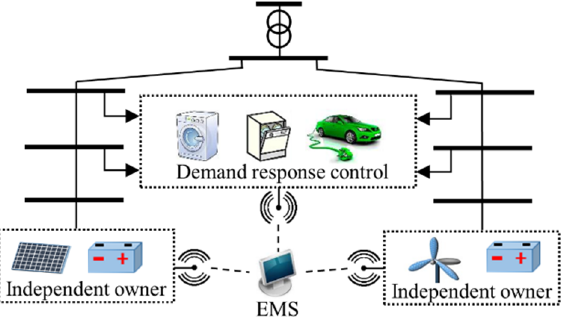
Figure 1. Conceptual image of a smart microgrid (MG) with distributed renewable generation (DRG) and distributed energy storage systems (DESSs).